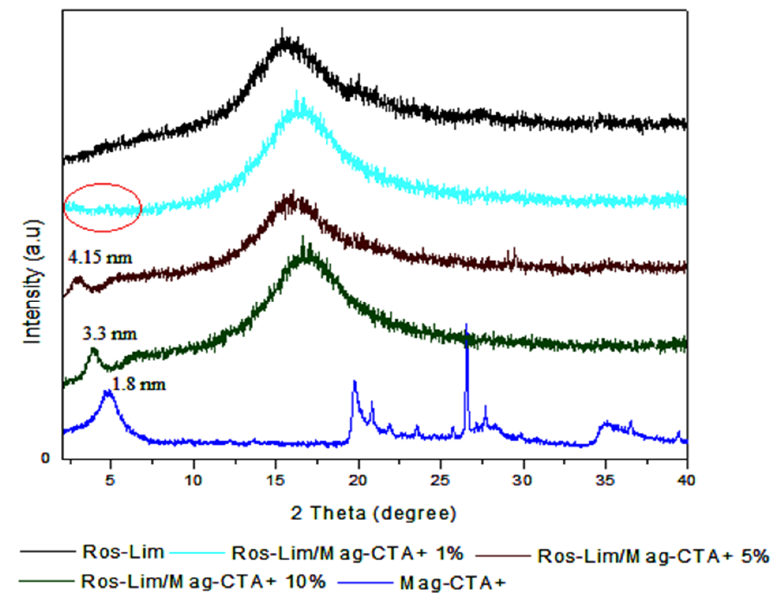
Figure 4. XRD patterns of nanocomposites Ros-Lim / Mag-CTA +